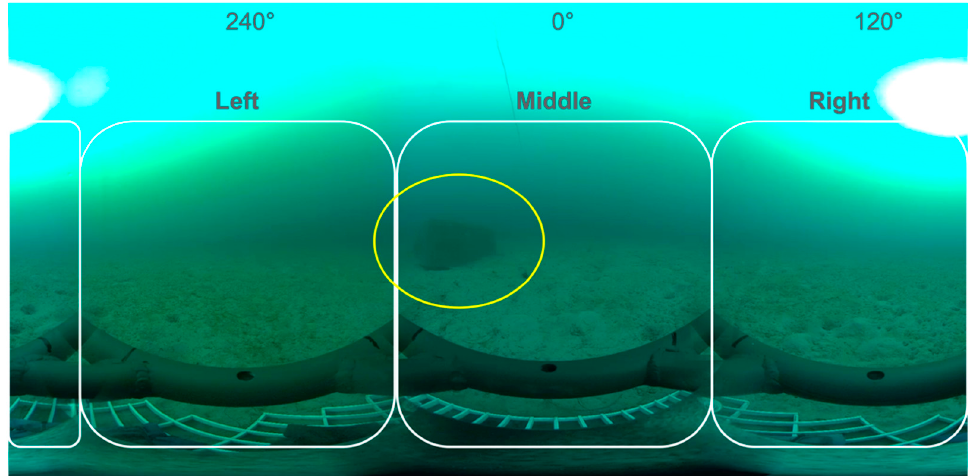
Figure 4. Example of a lander deployment with position of the left, middle, and right viewing frames (white rectangles) used for reviewing the 360-degree video footage, with the middle frame showing the targeted wave energy converter anchor (yellow oval). The frame and base of the lander are visible in the foreground.